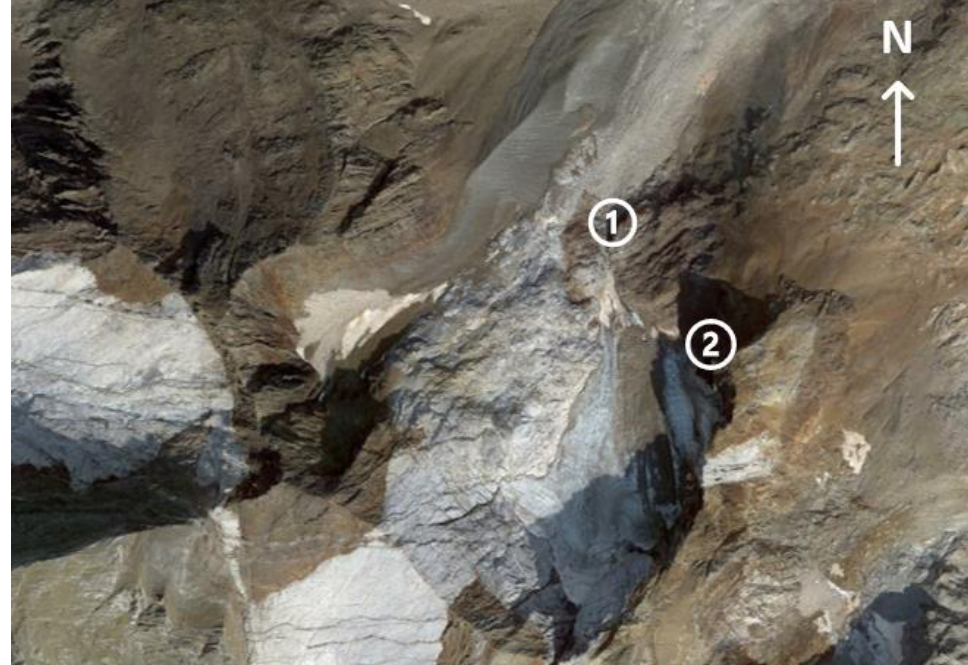
Figure 7. Infierno Glacier and surroundings. 8 September 2017. Glacier monitoring stations. 1: Glacier front monitoring station; 2: Glacier lateral monitoring station. Source: Google Earth [54].